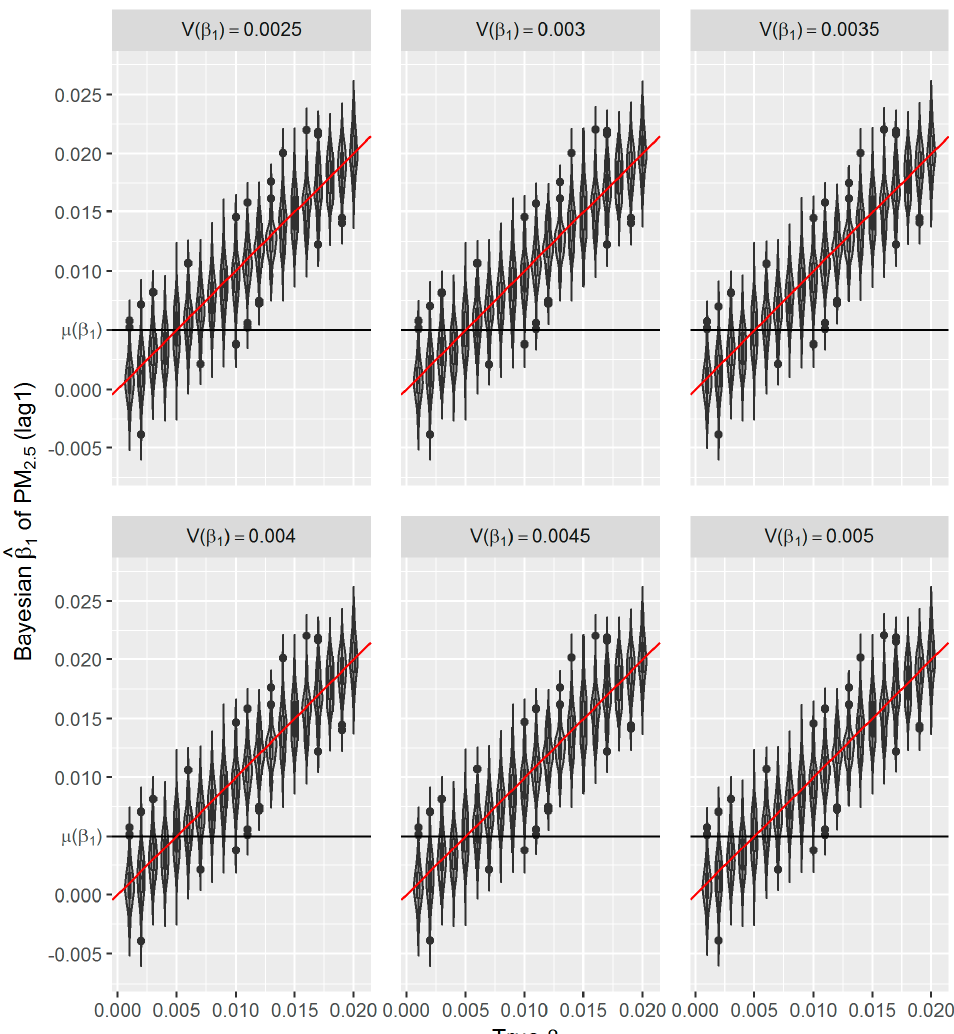
Figure 8. Distributions of Bayesian (cid:98) β 1 s from simulated data with σ = 0.5 (cid:98) σ , true β 1 = 0.001 to 0.02 by 0.001; in Bayesian GAM analyses df = 8 for S ( t ), µ ( β 1 ) = 0.005 and V( β 1 ) = 0.0025, 0.003, 0.0035, 0.004, 0.0045 and 0.005.